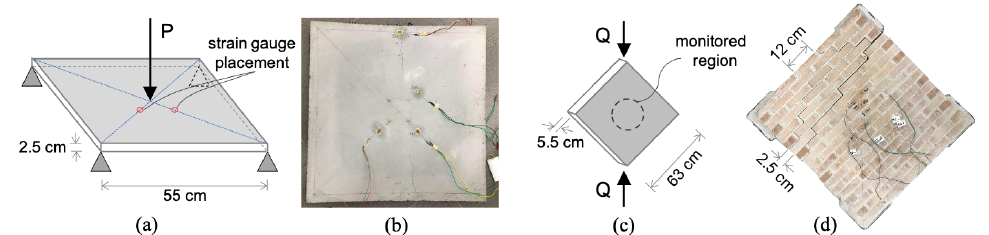
Figure 2: Five-point out-of-plane bending test (a) on an instrumented FRP reinforced concrete plate brought to fracture (b). In-plane diagonal compression test (c) on an instrumented masonry panel brought to fracture (d). (Detailed images and schematics of test setups are shown